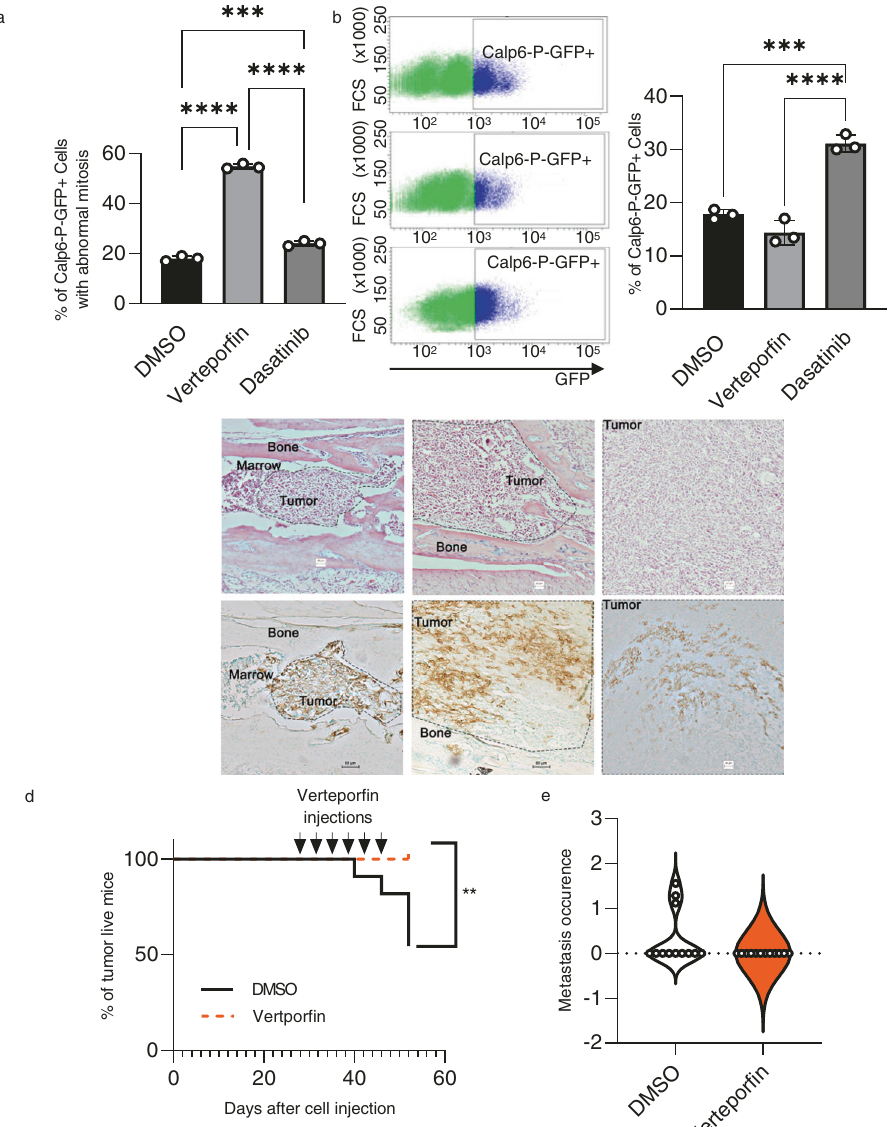
Fig. 6 Calpain-6/YAP axis is involved in bone tumor out-growth. a The effects of YAP inhibitors Dasatinib and Vertepor fi n vs the eluent (DMSO) on mitosis was observed in Calp6-P-GFP + K7M2 cells. The percentage of cells with abnormal mitosis was counted. Results are means ± SEM of the percentage of catastrophe mitosis in 3 different cultures. *** p < 0.001, **** p < 0.0001. b The effect of Dasatinib and Vertepor fi n on the % of K7M2 Calp6-P-GFP + cells. The cells were treated for 3 days with a YAP inhibitor or the eluent (DMSO) and the GFP + cells were counted by cytometry. c Tumor evolution in bone at different times after the implantation of Calp6-P-GFP K7M2 cells. Upper panels show H&E staining of bone sections 7 and 14 days after cell implantation and large/mature bone tumor. Lower panels show GFP immunohistochemistry (brown staining) in corresponding adjacent sections. Dotted lines indicate the extent of the tumor. d Mice with slowly developing tumors were treated with DMSO or vertepor fi n as indicated (arrows). The survival curves indicate the percentage of living mice. n = 12 DMSO-treated mice, n = 11 vertepor fi n-treated mice. ** p < 0.01. e Quanti fi cation of lung metastases in these